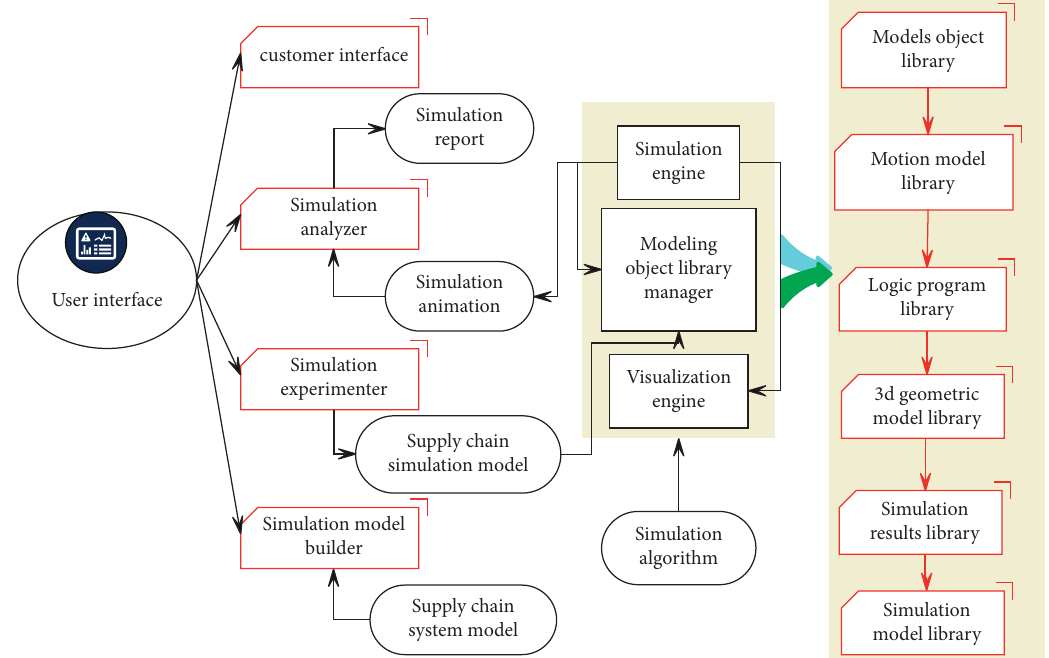
Figure 7: The architecture of the supply chain visual simulation system.